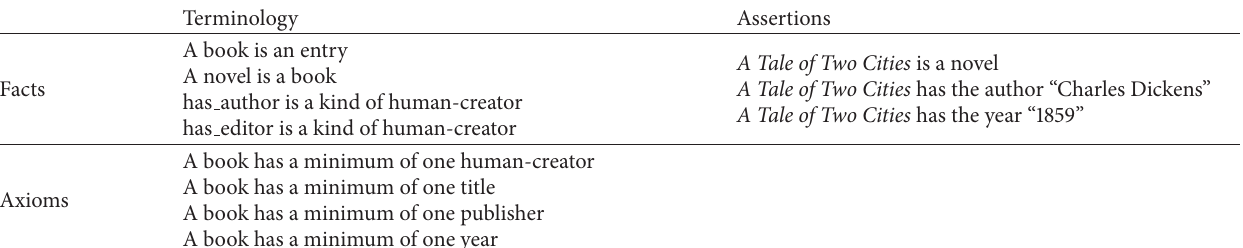
Table 1: Sample facts and axioms from the bibtex